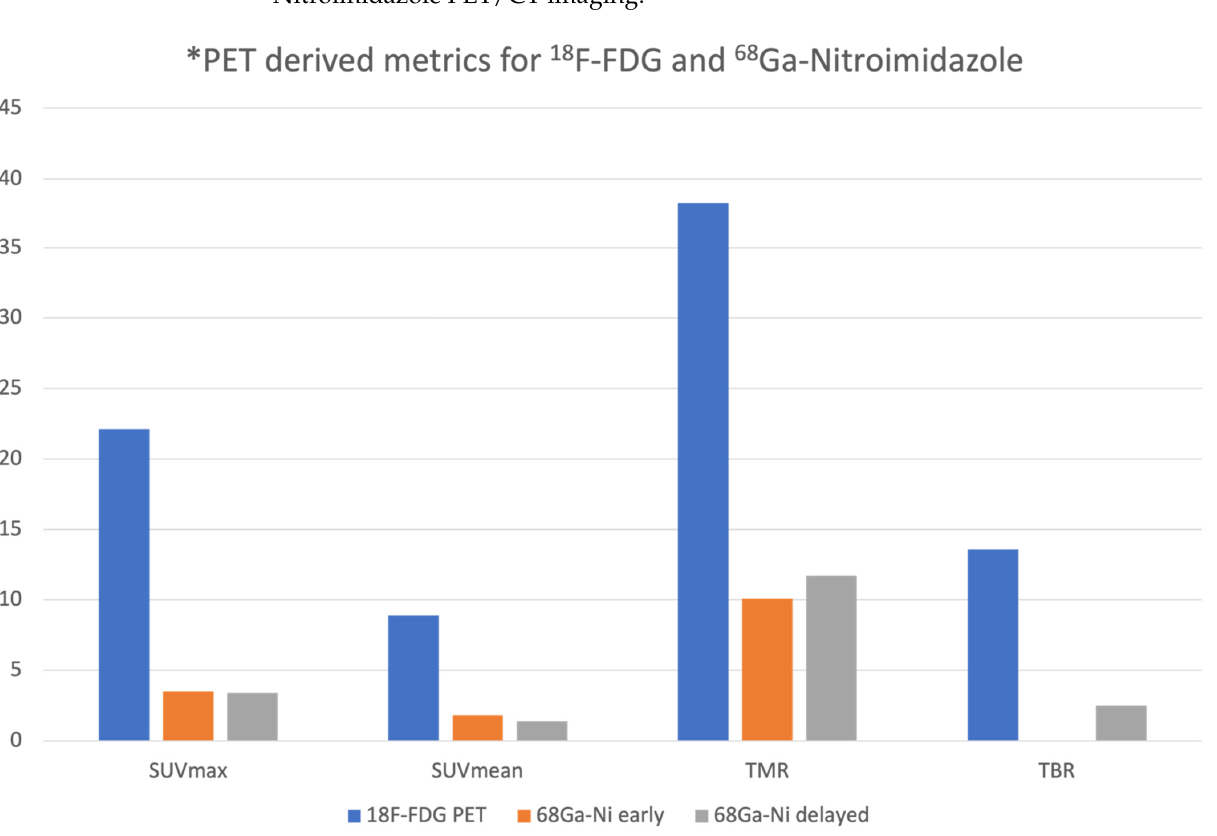
Figure 1. The mean SUVmax, SUVmean, tumor to muscle ratio (TMR) and tumor to blood ratio (TBR) for 18 F-FDG and 68 Ga-Nitroimidazole at 30 and 60 min. * PET: Positron Emission Tomography The median MTV on the 18 F-FDG PET/CT was 150.5 (18.41–548.93). The median hy-